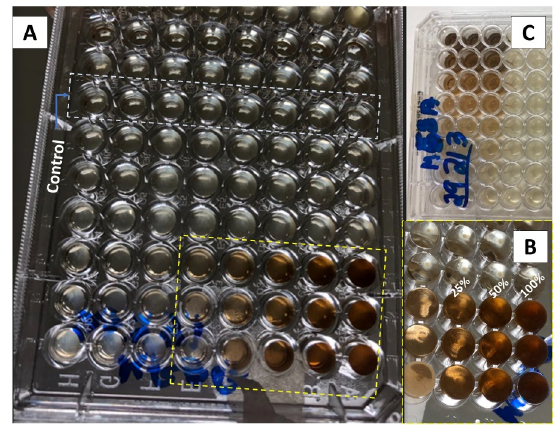
Figure 2. Inhibitory dose study in microplates with dilution for MSSA S. aureus . ( A ) Photograph of the bottom of the microplate highlighting the wells with the control group and the 48 wells with the extract using the methicillin-susceptible S. aureus strain (MSSA). ( B ) Enlarged photograph for the wells with 100, 50, and 25% of the extract. ( C ) Photograph of the top of the plate with the bacterial strain (MSSA).